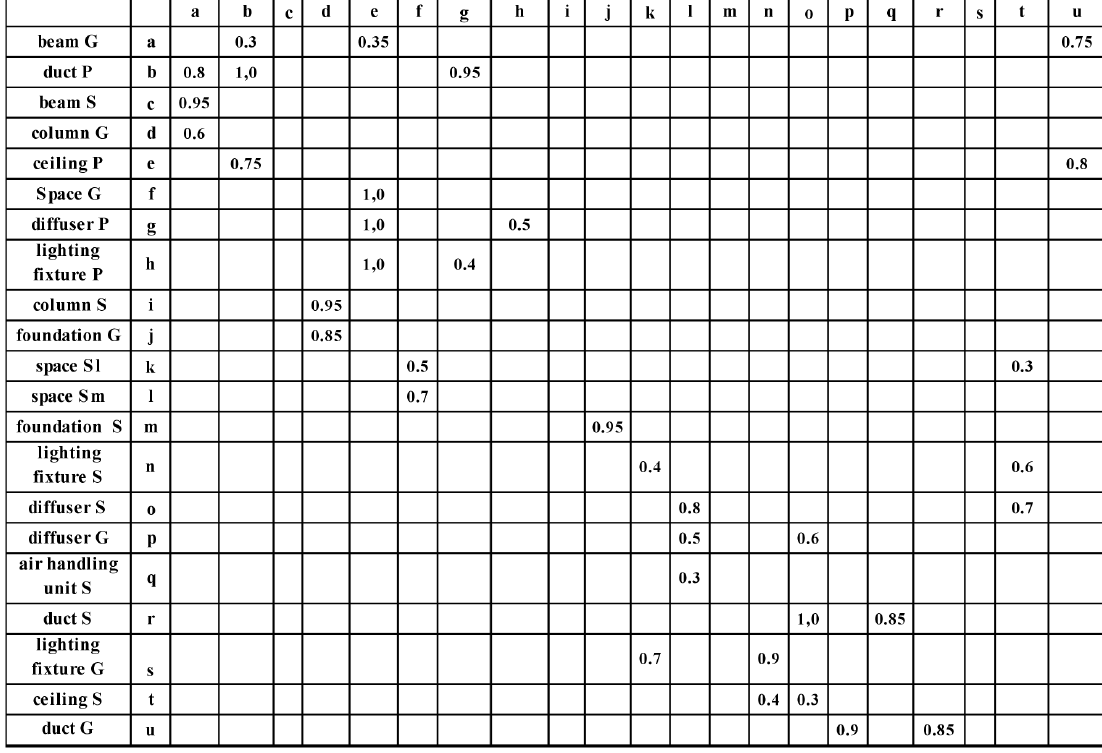
Fig. 10. The likelihood of change